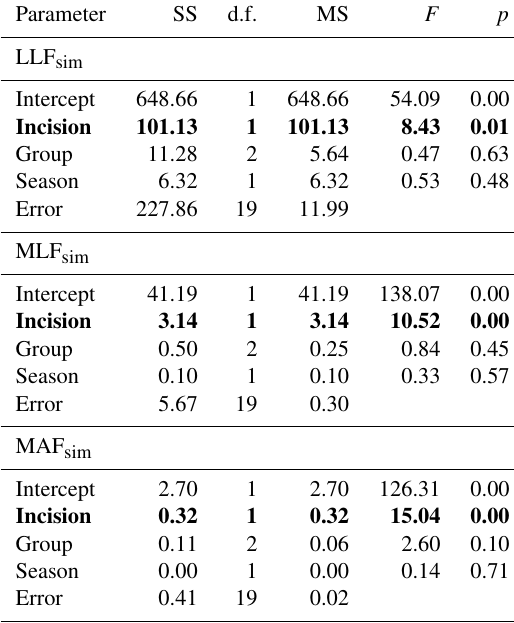
Table 5. General linear modelling results for hydrological flow sim- ilarity ( S ) in relation to bed modification (incision and redeposi- tion), season, and abiotic river group. SS – sum of squares, d.f. – degrees of freedom, MS – mean square. p values marked with bold indicate statistically significant relations.